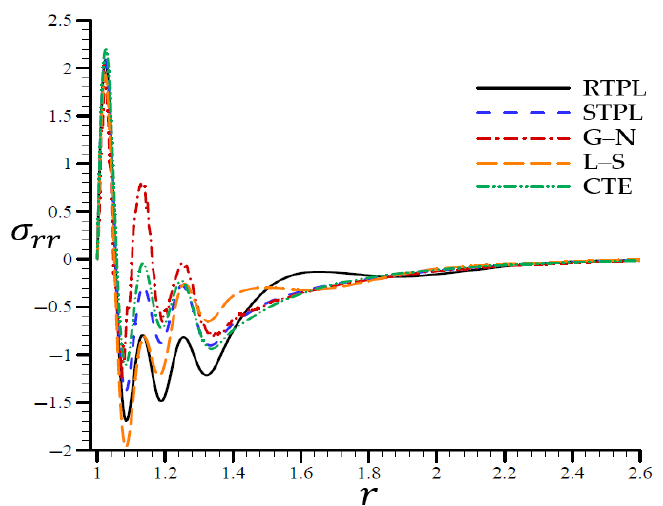
Figure 5. The radial stress 𝜎 𝑟𝑟 through the radial direction of the spherical hole for all models.